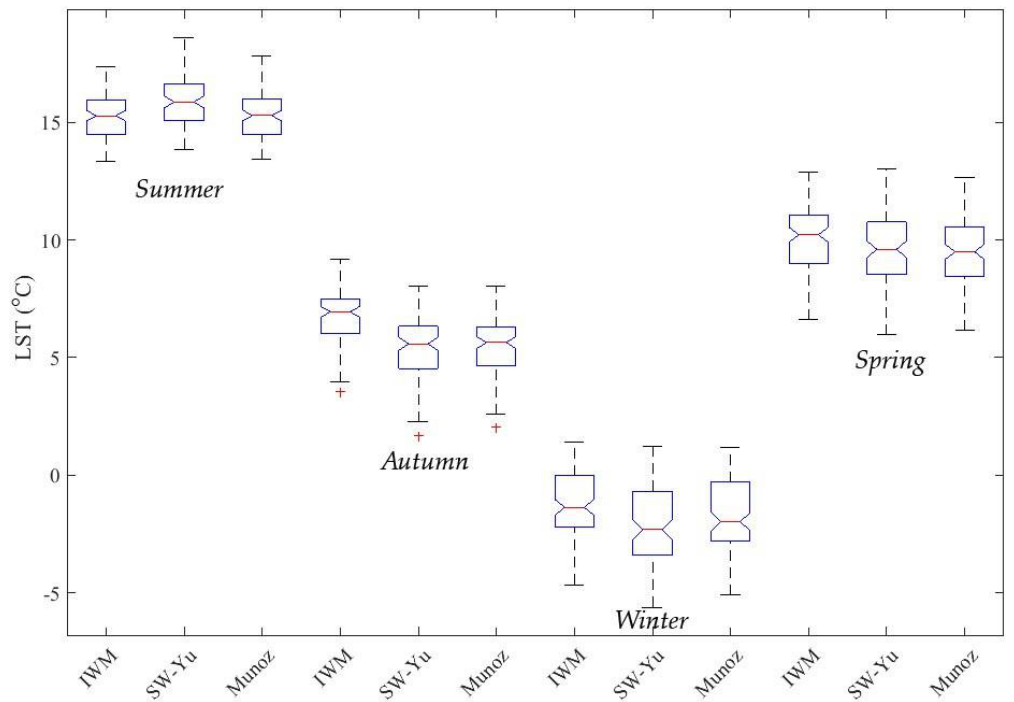
Figure 22. Intra-seasonal variation in land surface temperatures (LSTs) estimated using all three methods for each season. The variation was calculated using 101 random point samples of the study area. IMW—improved mono-window algorithm; SW-Yu—split-window algorithm of Yu et al. [19]; SW-Muñoz—split-window algorithm of Jiménez-Muñoz et al. [20].